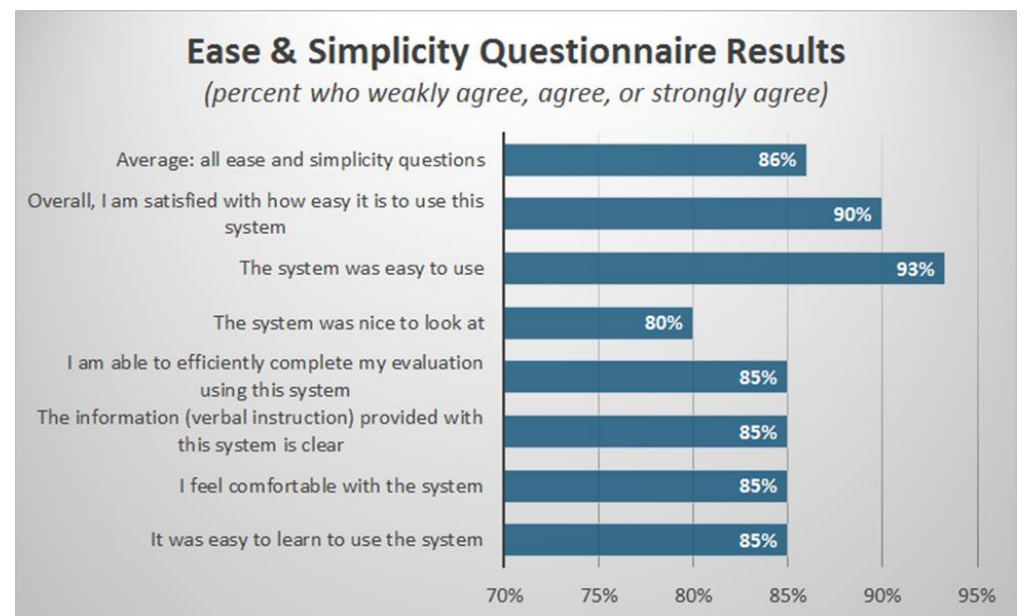
Figure 3. Results of “Ease and Simplicity” section of telehealth usability questionnaire reported as percent of respondents who rated > 4 on a 7-point Likert scale (corresponding to “weakly agree”, “agree”, or “strongly